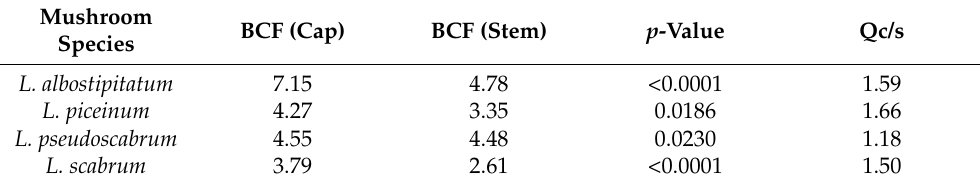
Table 4. Bioaccumulation factor (BCF) values in caps and stems, p-values of the Wilcoxon test between caps and stems within the species and translocation quotient (Qc/s) values determined for four Leccinum